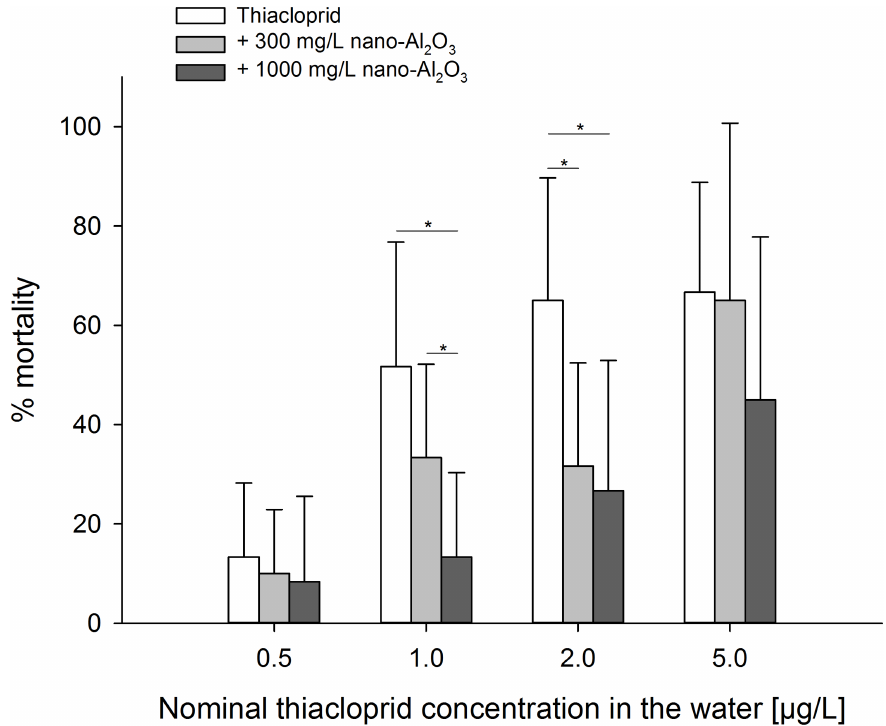
Fig 2. Mortality rates (means ± SD) of larvae per test vessel. Larvae were exposedto either thiacloprid solely, a mixture of thiaclopridand 300 mg/L nano-Al 2 O 3 , or a mixture of 1000mg/L nano-Al 2 O 3, after 96 h of exposure(n = 12). Four comparisons (Likelihoodratio test and Fishers exact test, if necessary)were conducted(one for each thiaclopridconcentration) and significantdifferences betweenthe data displayed at the respectivetwo ends of the horizontal lines are given ( * p (cid:20) α when adjustedaccordingto Holm- Bonferroni’s method [23], Fishers exact test). Nominalvalues are shown in this graph, whereasmeasured concentrations can be obtainedfrom Table